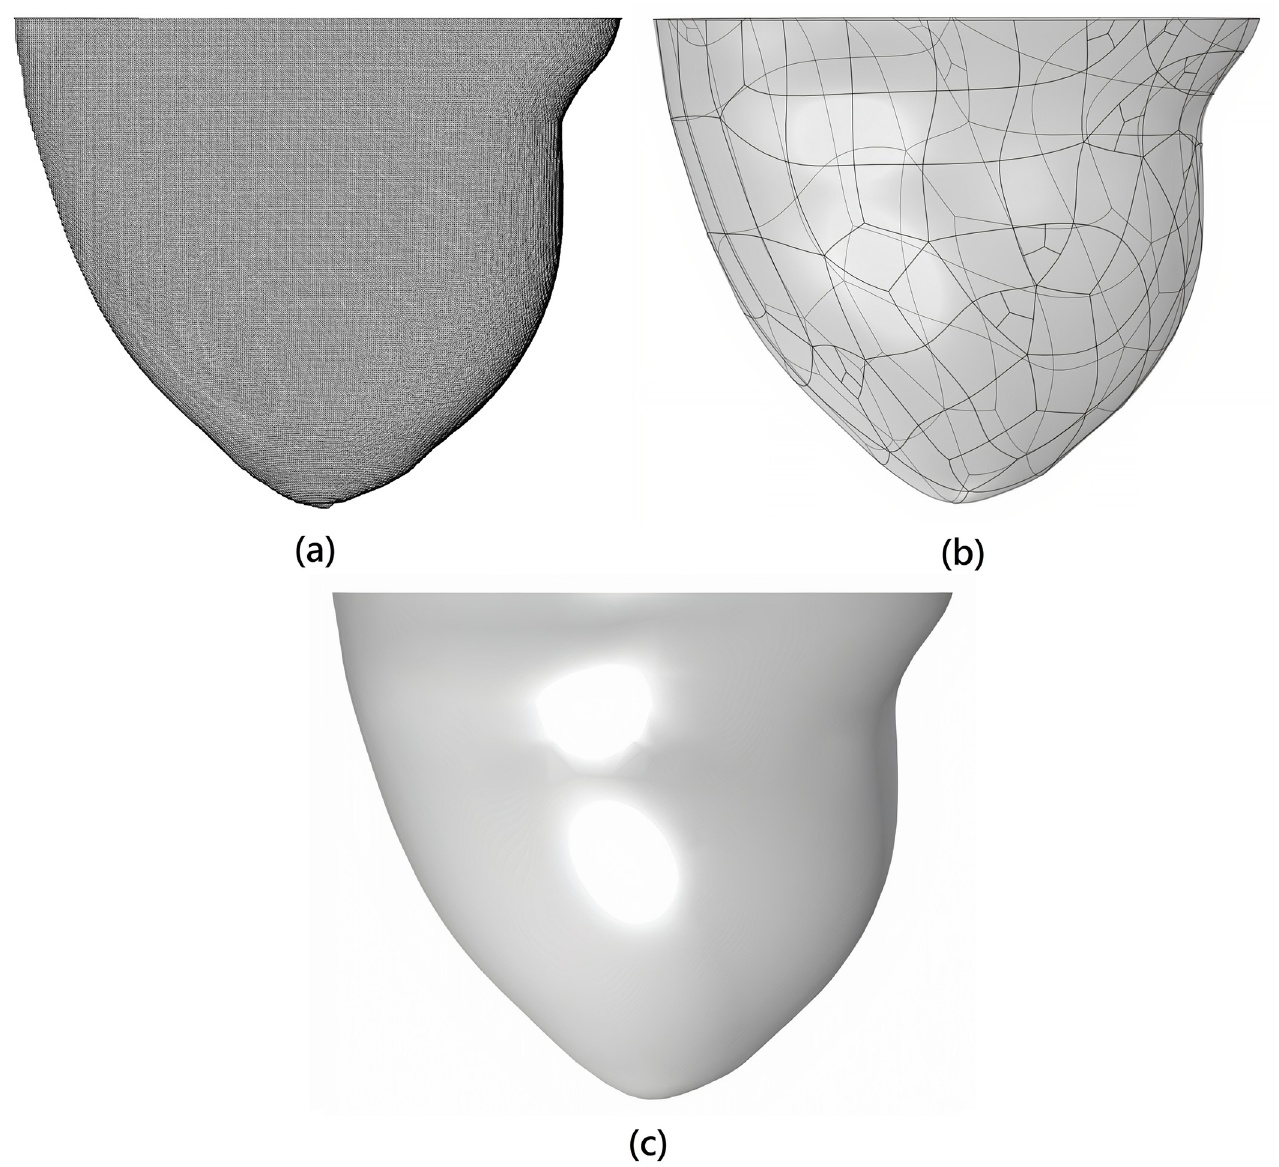
Fig 3. Different steps of creating a 3D breast phantom: (a) point cloud obtained from the database, (b) surfaces created from the point cloud, and (c) the volume created from knitted surfaces.